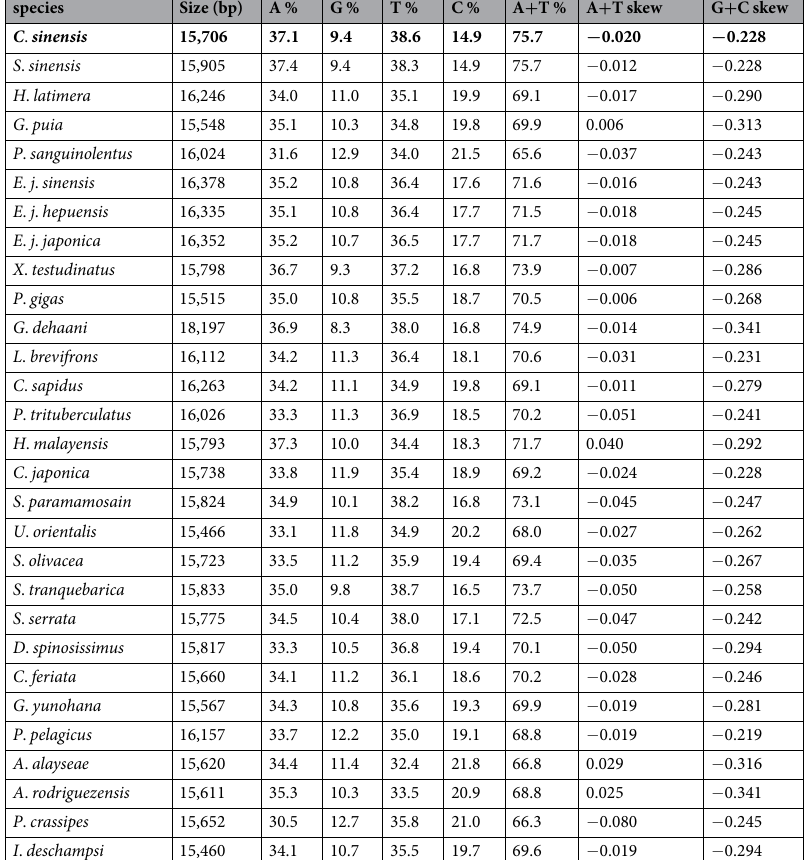
Table 4. Composition and skewness of mitogenome in 29 Brachyura